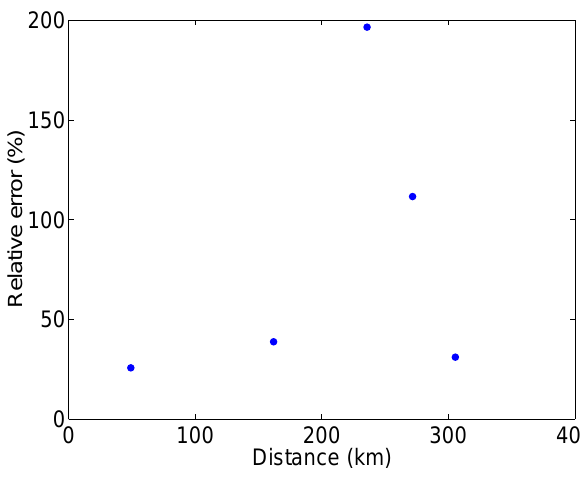
Table 1. The number of 1-D overfligts between 55 ◦ and 76.5 ◦ ge- omagnetic latitude during 2001 and 2002 with | I φ |= 0 ... 0 .